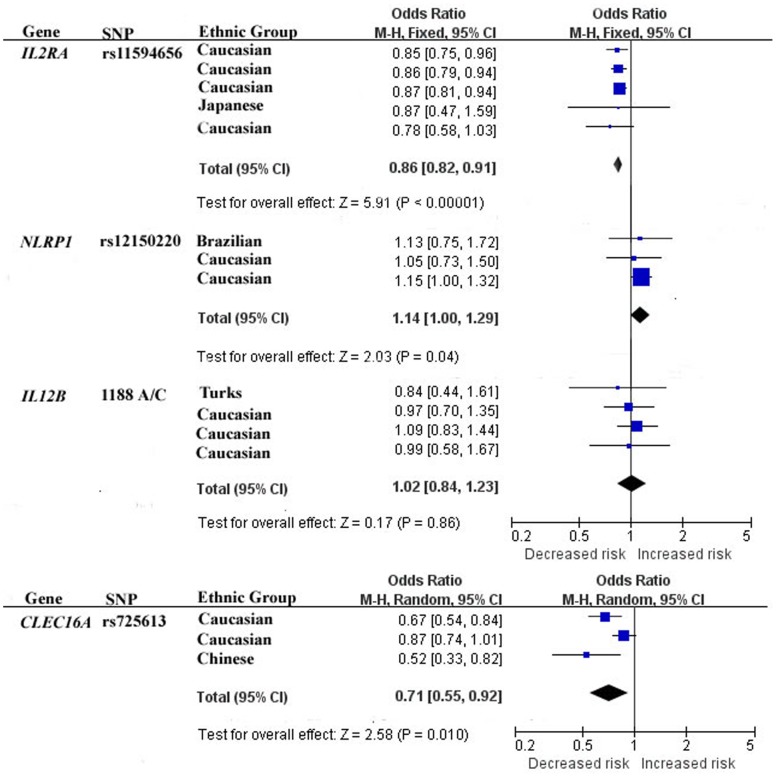
Forest plots of the association studies between four SNPs and T1D.